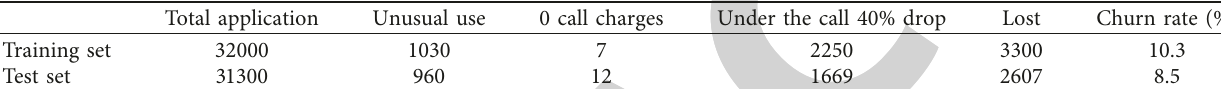
Table 2: Customer churn profile.